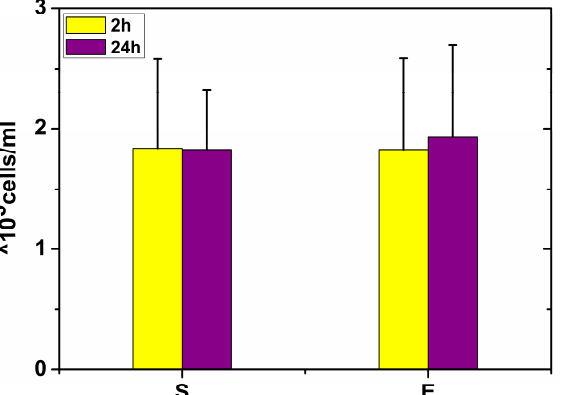
Figure 2. The number of live hMSC in sham and exposure probes after detachment from the culture vessel 2 h and 24 h after exposure to EMP (cells/mL). Measurements were made in two independent experiments with three independent biological specimens exposed in each experiment.